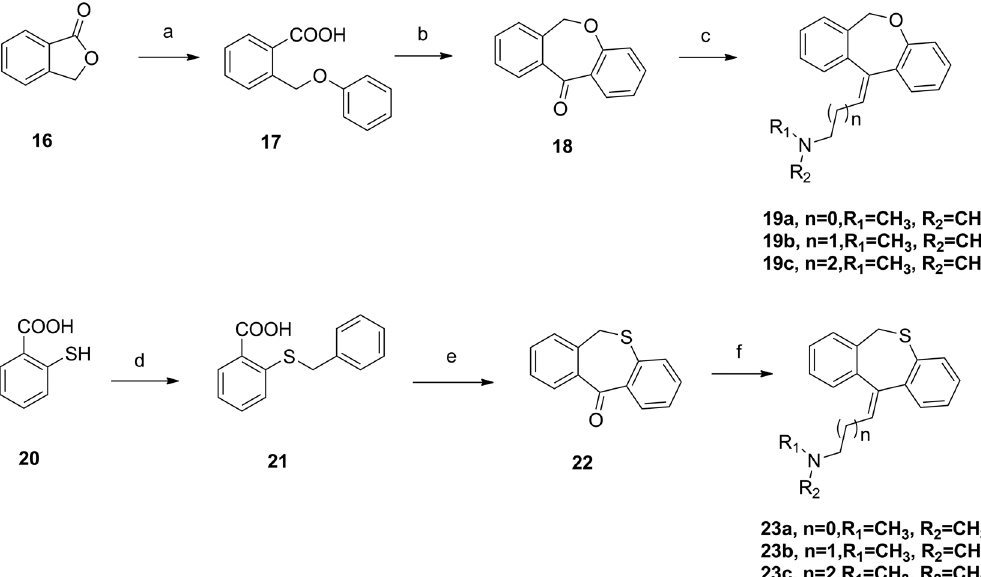
Figure 6. Synthesis of dibenzo[b,e]oxepin-11(6H)-ylidene and dibenzo[b,e]thiepin-11(6H)-ylidenederivatives. Reagents and conditions: ( a ) KOH, Xylene, reflux, then HCl, H 2 O; ( b ) CH 2 Cl 2 , trifluoroacetic anhydride, BF 3 . Et 2 O,40 °C; ( c ) THF, 10, n-BuLi; ( d ) EtOH, NaOH, overnight; ( e ) PPA, 100 °C; ( f ) THF, 10, n-BuLi.